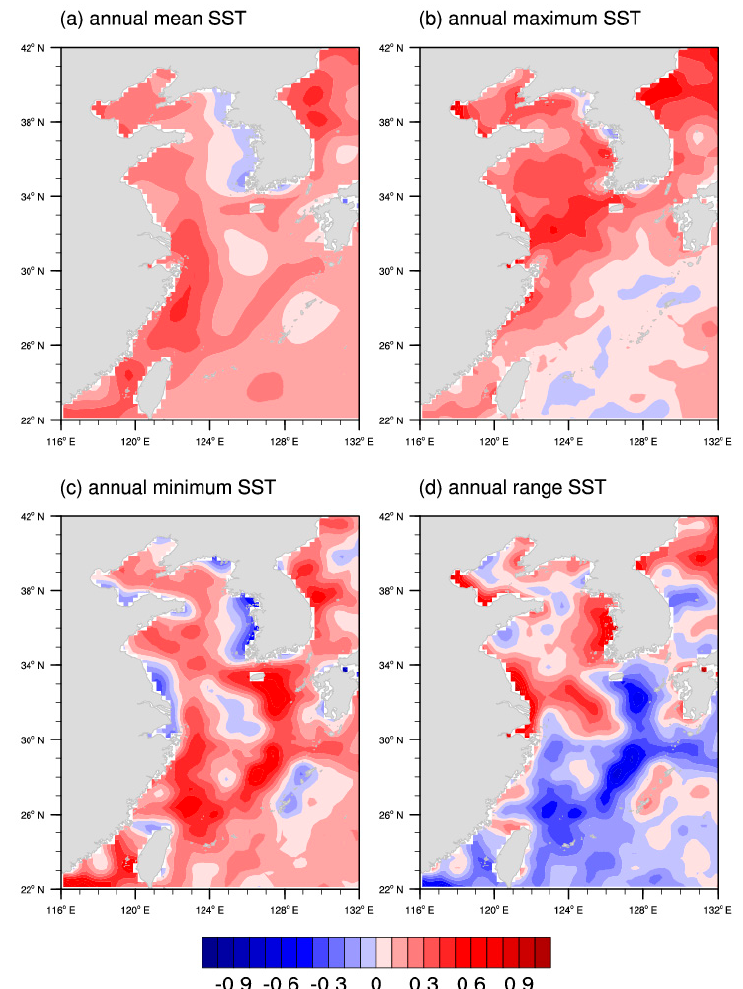
Figure 5. Linear trends spatial distribution of ( a ) annual mean SST, ( b ) annual maximum SST, ( c ) annual minimum SST, ( d ) AR SST in the ECSs (Units: °C per decade).